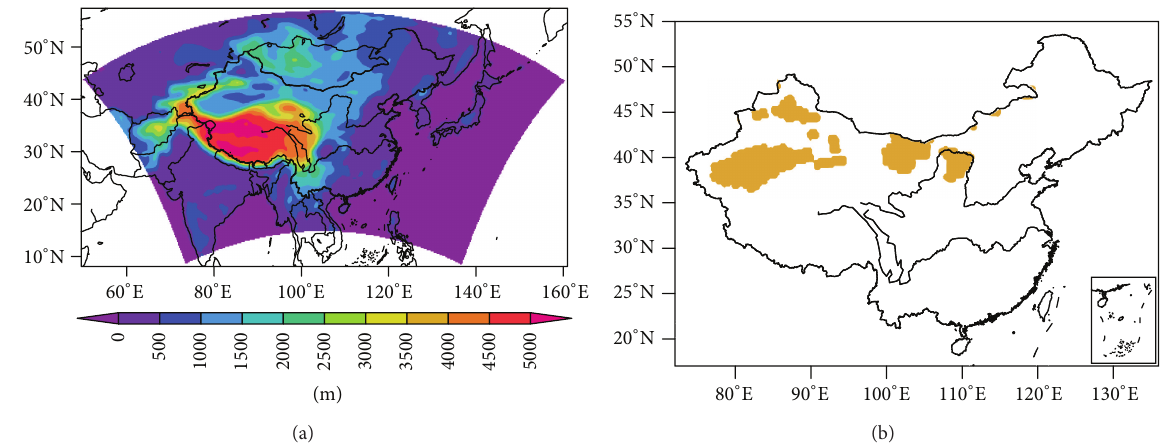
Figure 1: (a) The model domain (blue areas) and terrain height in meters and (b) the dust source distribution (yellow areas) in this study.